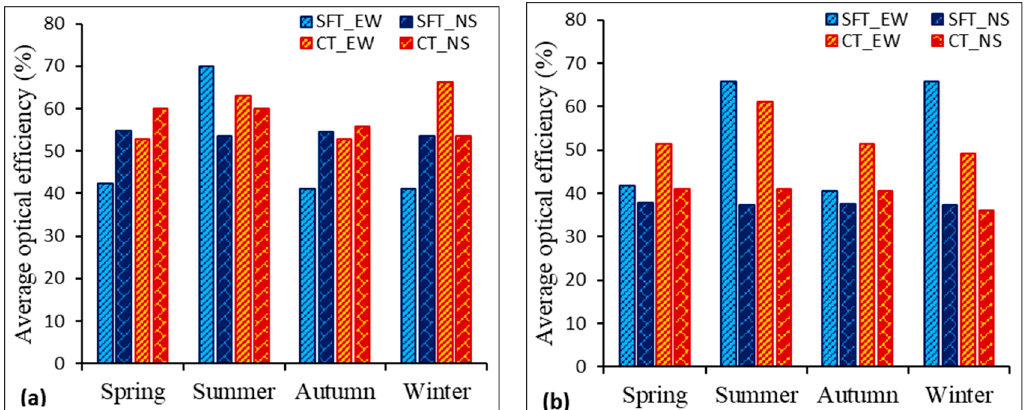
Figure 13. The average optical efficiency of CPC coupled with SFT and CT receivers under different configurations for: ( a ) concentrated time (4 h); ( b ) overall effective operating time (7 h). configurations for: ( a ) concentrated time (4 h); ( b ) overall e ff ective operating time (7